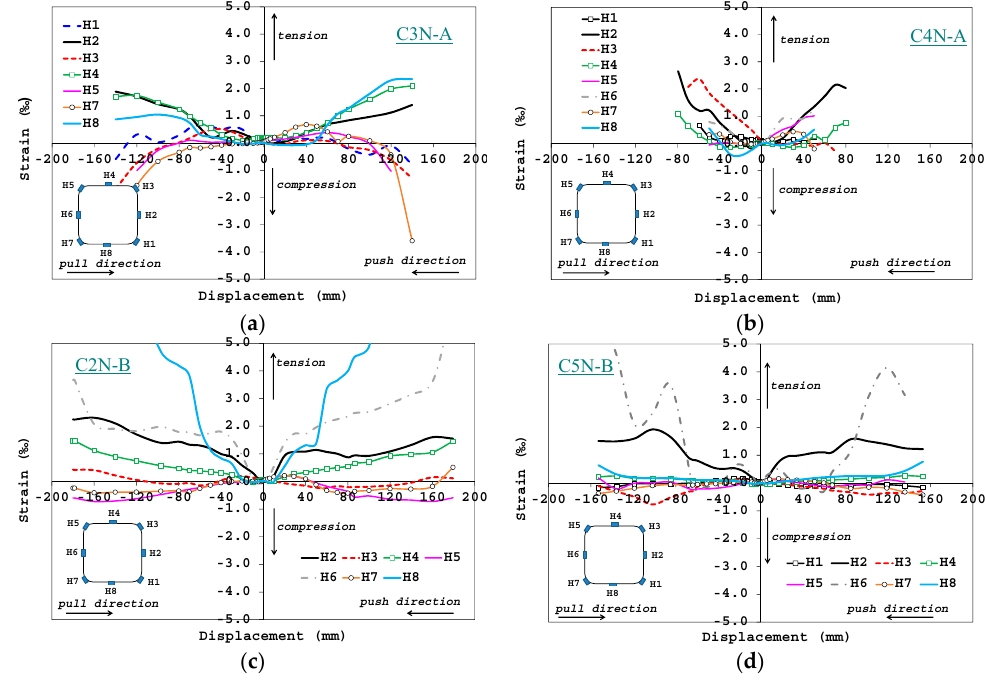
Figure 20. FRP strains: tests C3N-A ( a ); C4N-A ( b ); C2N-B ( c ); and C5N-B ( d ).